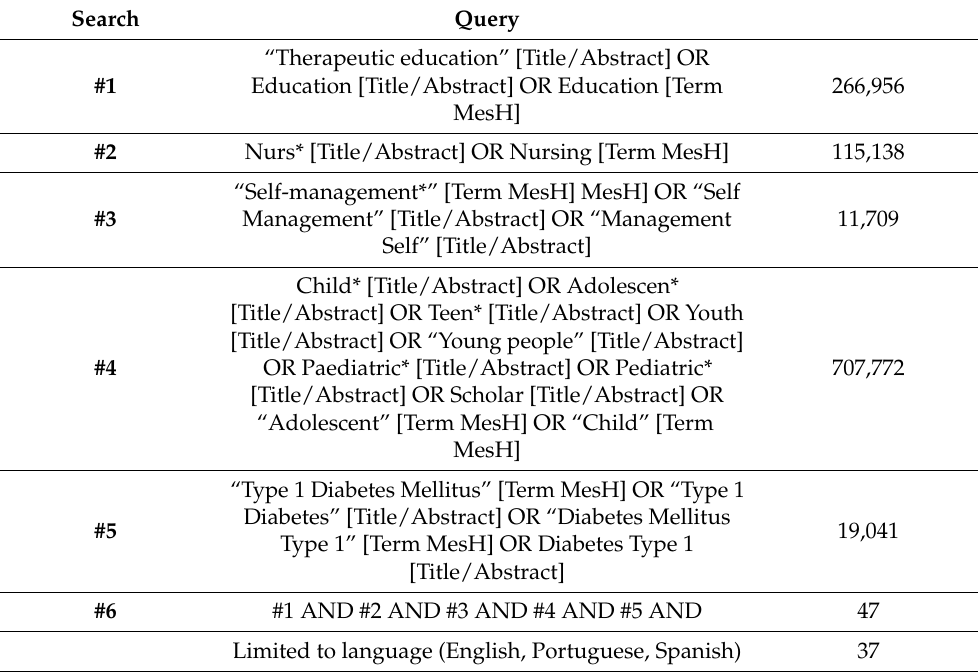
Table A1. Ordered descriptors and respective Boolean operators for the search on the PubMed platform (with access to the Medline specialized